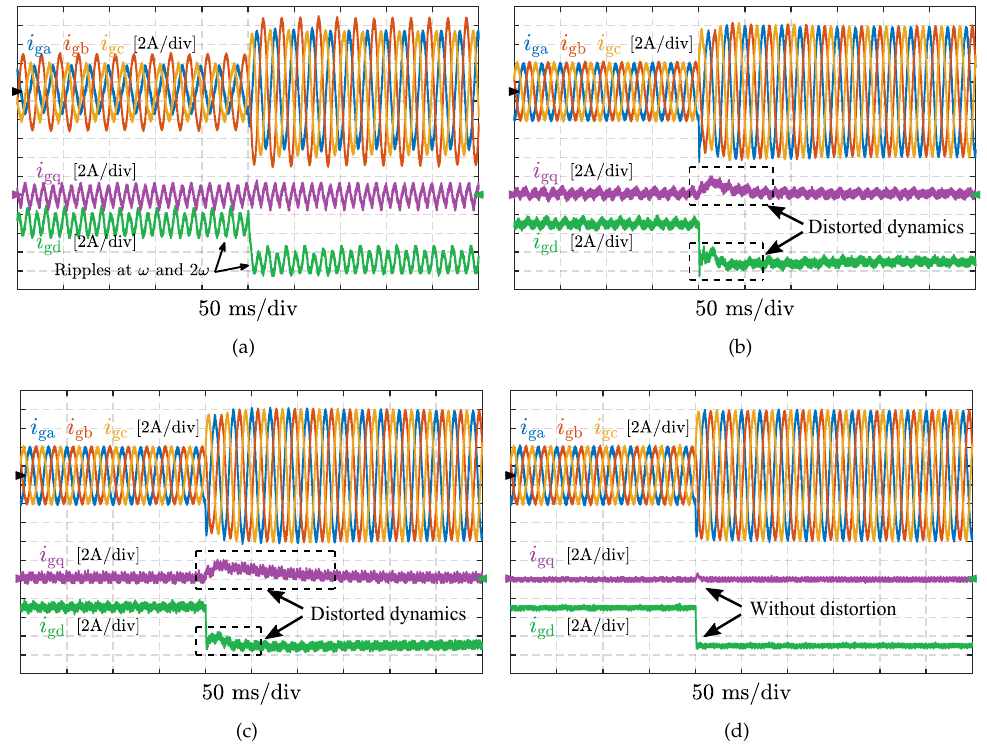
Figure 12. Experimental step responses of the reference tracking under voltage measurement errors: ( a ) Traditional controllers without additional compensation schemes; ( b ) The conventional compensation scheme based on MRSCs; ( c ) The conventional compensation scheme based on the plug-in RC; ( d ) The proposed dual-loop